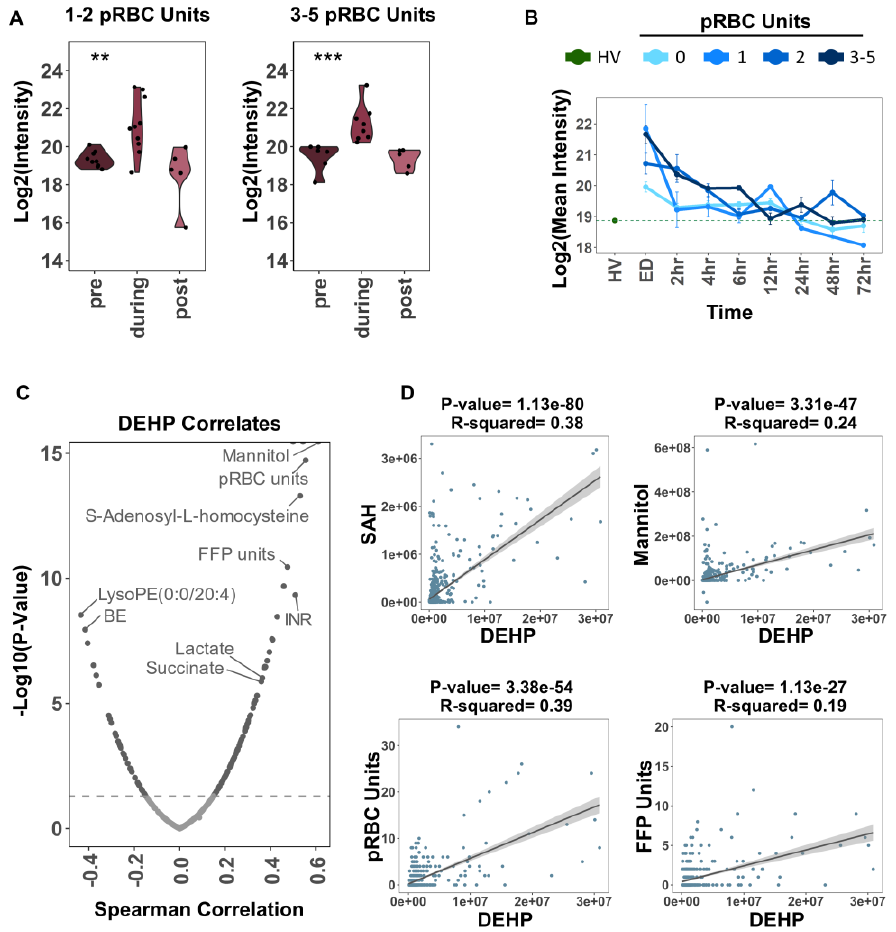
Figure 5. Impact of pRBC transfusion on circulating levels of common plasticizers that leach from the blood bag during storage of erythrocyte concentrates. In ( A ), Log2 transformed DEHP intensities pre, during, and post transfusion. For patients that received 1 – 2 or 3 – 5 pRBC units during transfusion. Significance between phases were measured by ANOVA. *** p < 0.001, ** p < 0.01. In ( B ), Log2 transformed mean DEHP intensity for healthy volunteers compared to trauma patient temporal trends separated by the number of pRBC units received during transfusion. Error bars represent the standard error at each time point. In ( C ), DEHP for trauma patient time point samples from ED and 2 h were correlated (Spearman method) with all metabolites and selected clinical labs: base excess (BE), INR, FFP units, pRBC units. In ( D ), selected significant positive correlates (as determined in panel ( C )) were fit by a simple linear model. The 95% CI of the slope is shaded in grey surrounding the regression line. The p -value and R squared of the slope are reported above each plot.